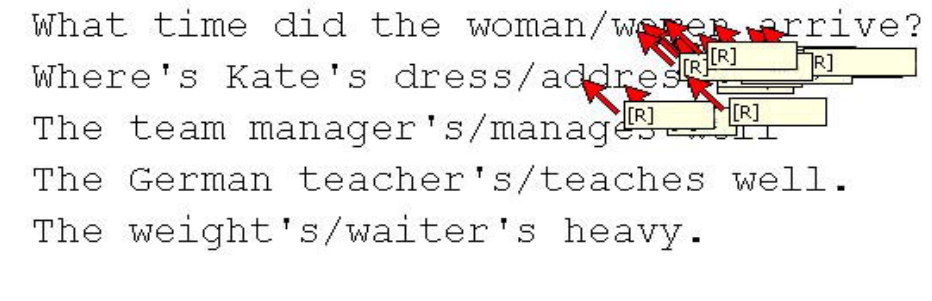
Figure 9 . What did I say? Woman or women ? (names removed from